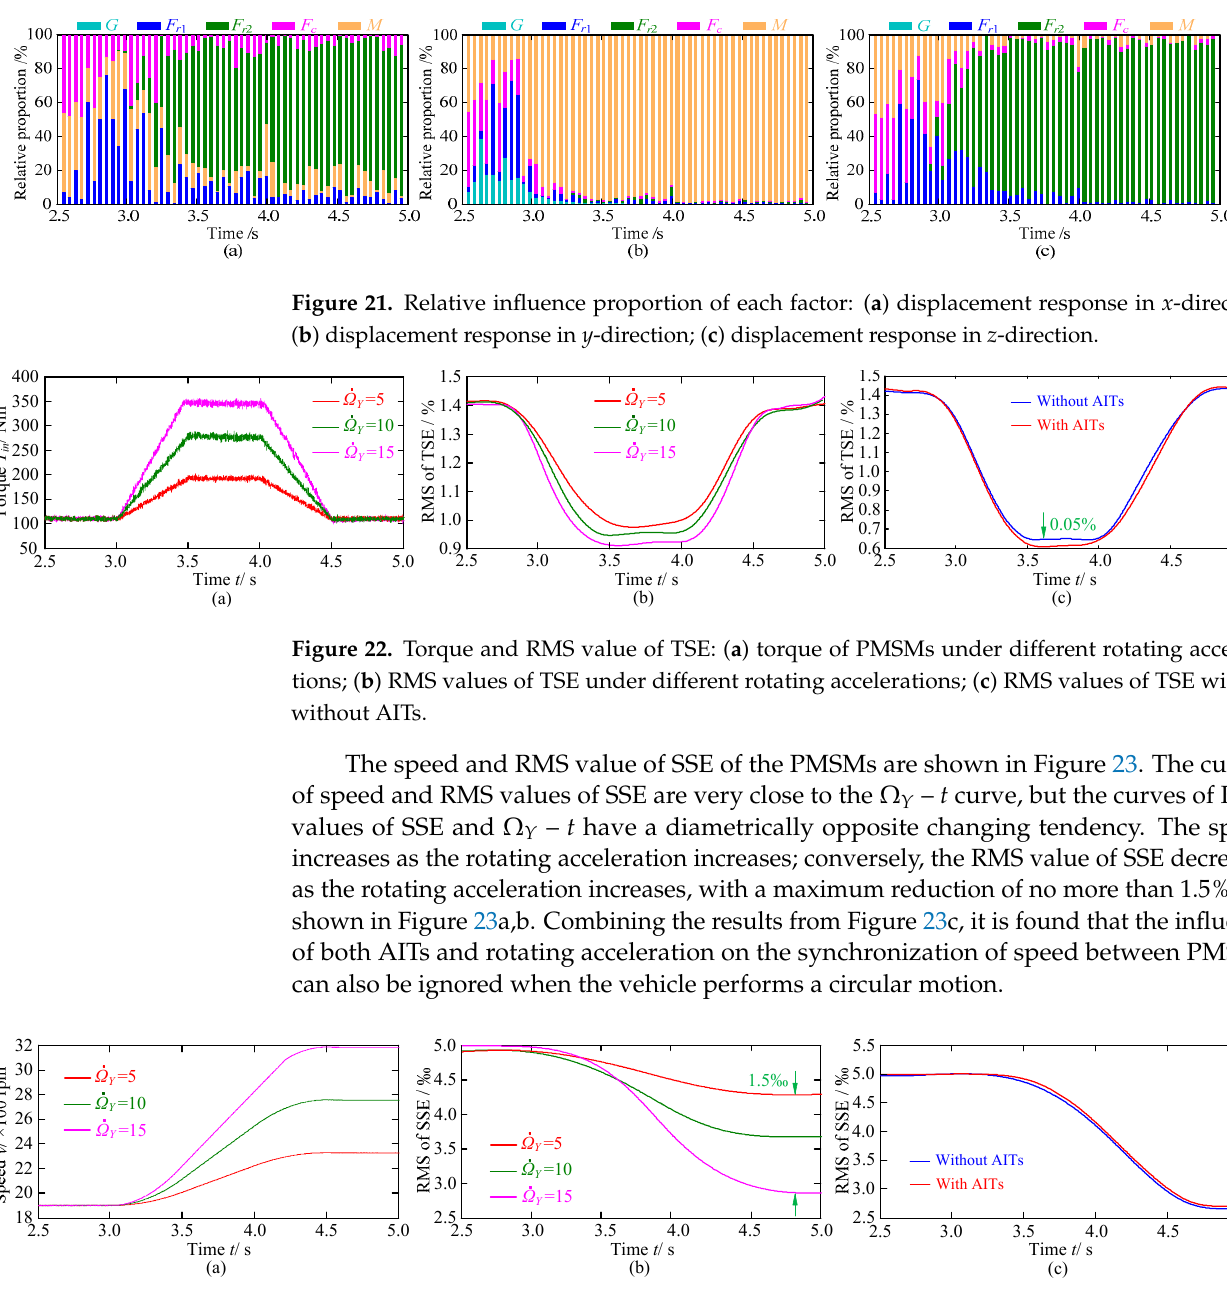
Figure 21. Relative influence proportion of each factor: ( a ) displacement response in x -direction; ( b ) displacement response in y -direction; ( c ) displacement response in z -direction.